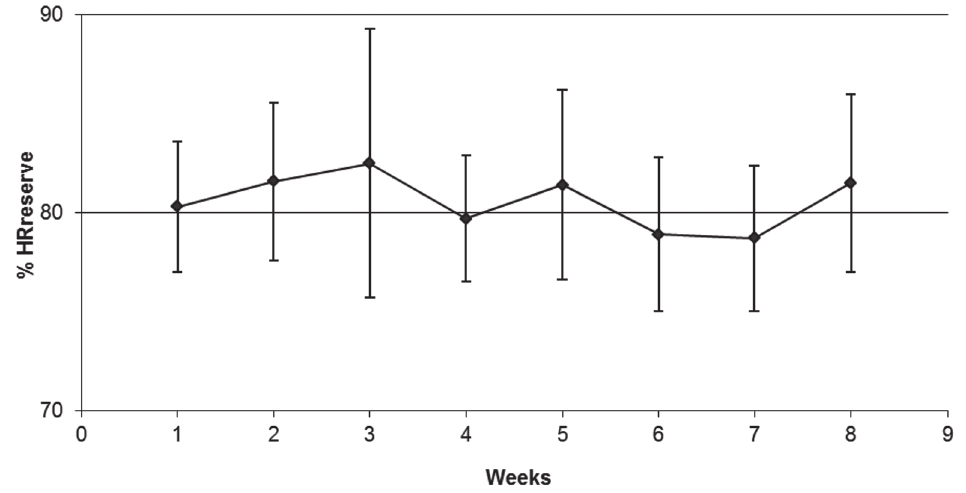
FIGURE 1 Game intensity throughout the 8-weeks of intervention period